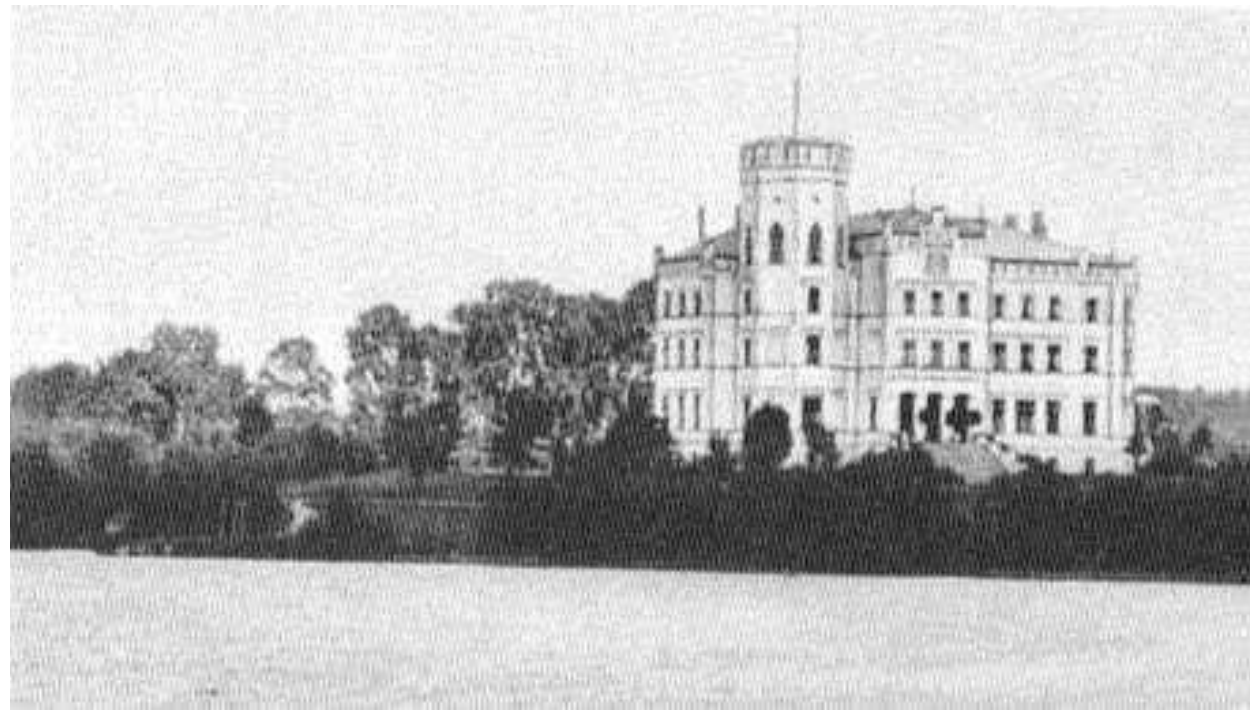
Figure 1. View of the Palace in Maciejewo from Lake Lechickie, before 1945; photo: Archives of the Regional Monumental Conservation Office in Szczecin.